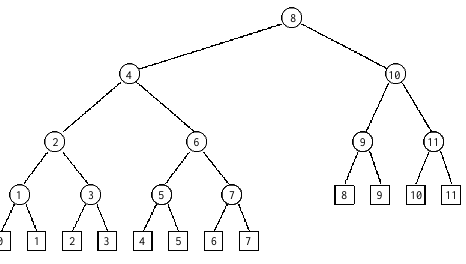
Fig. 1: A binary tree with 11 internal nodes, that are labelled by inorder traversal. Node 4 has seven descendants and two ascendants, leaf 6 has a height of 5.